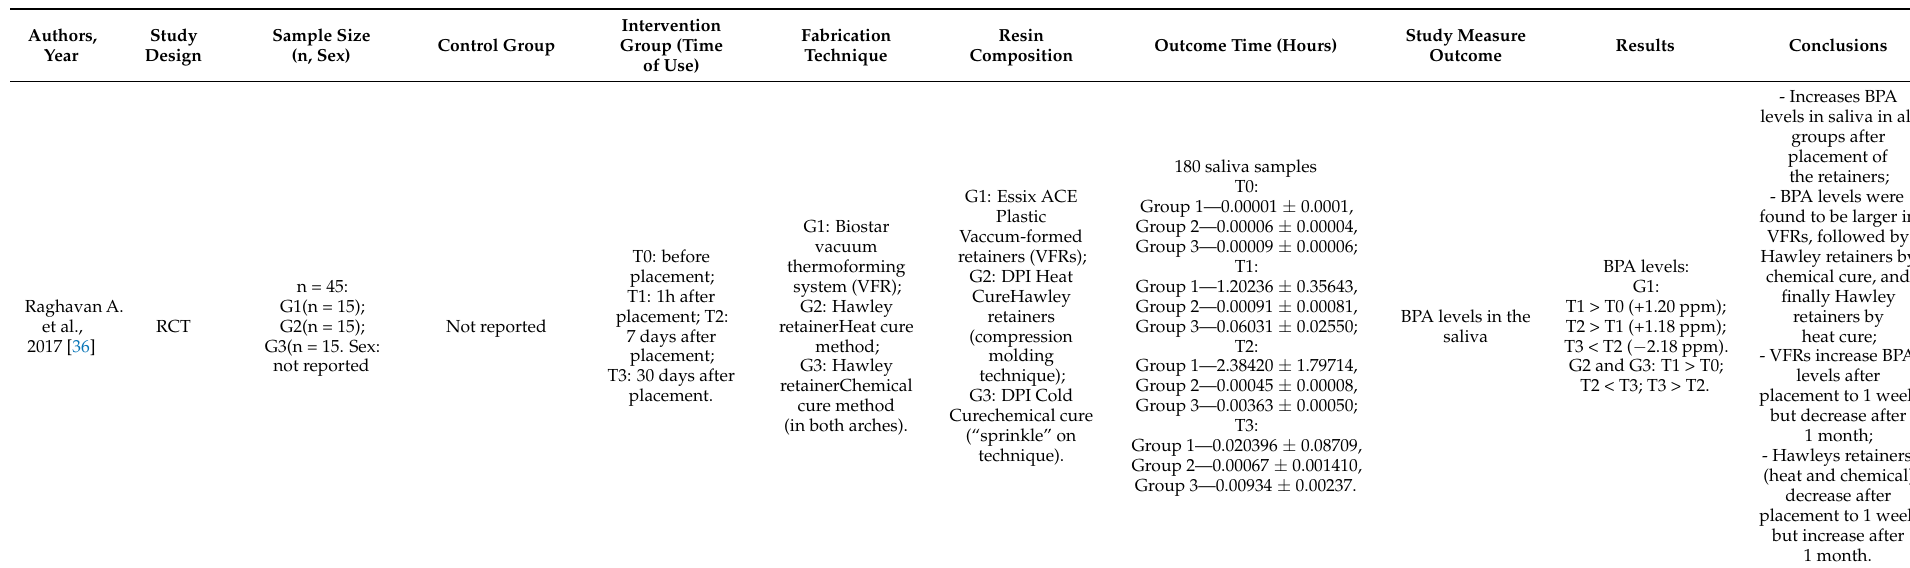
Table 3. Summary of parameters and results from clinical included